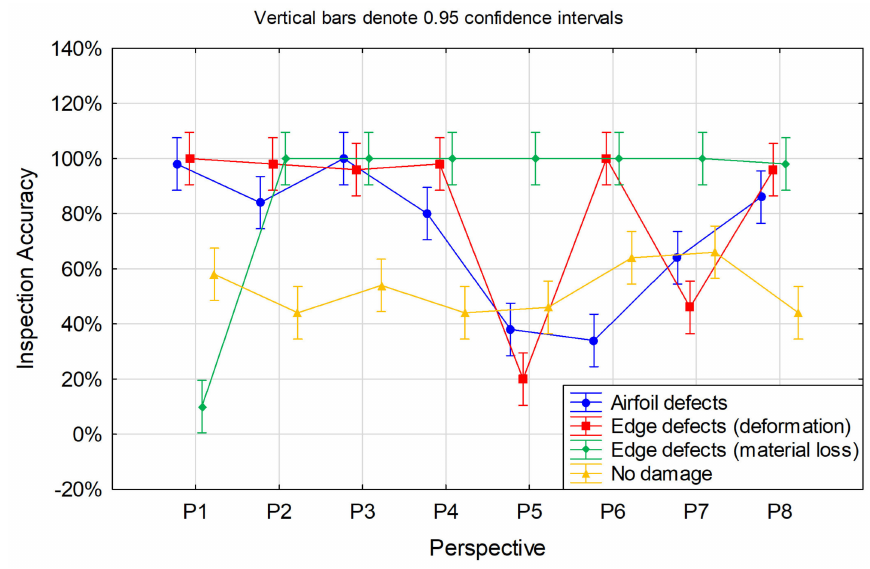
Figure 13. Effect of blade perspective on inspection accuracy for each defect